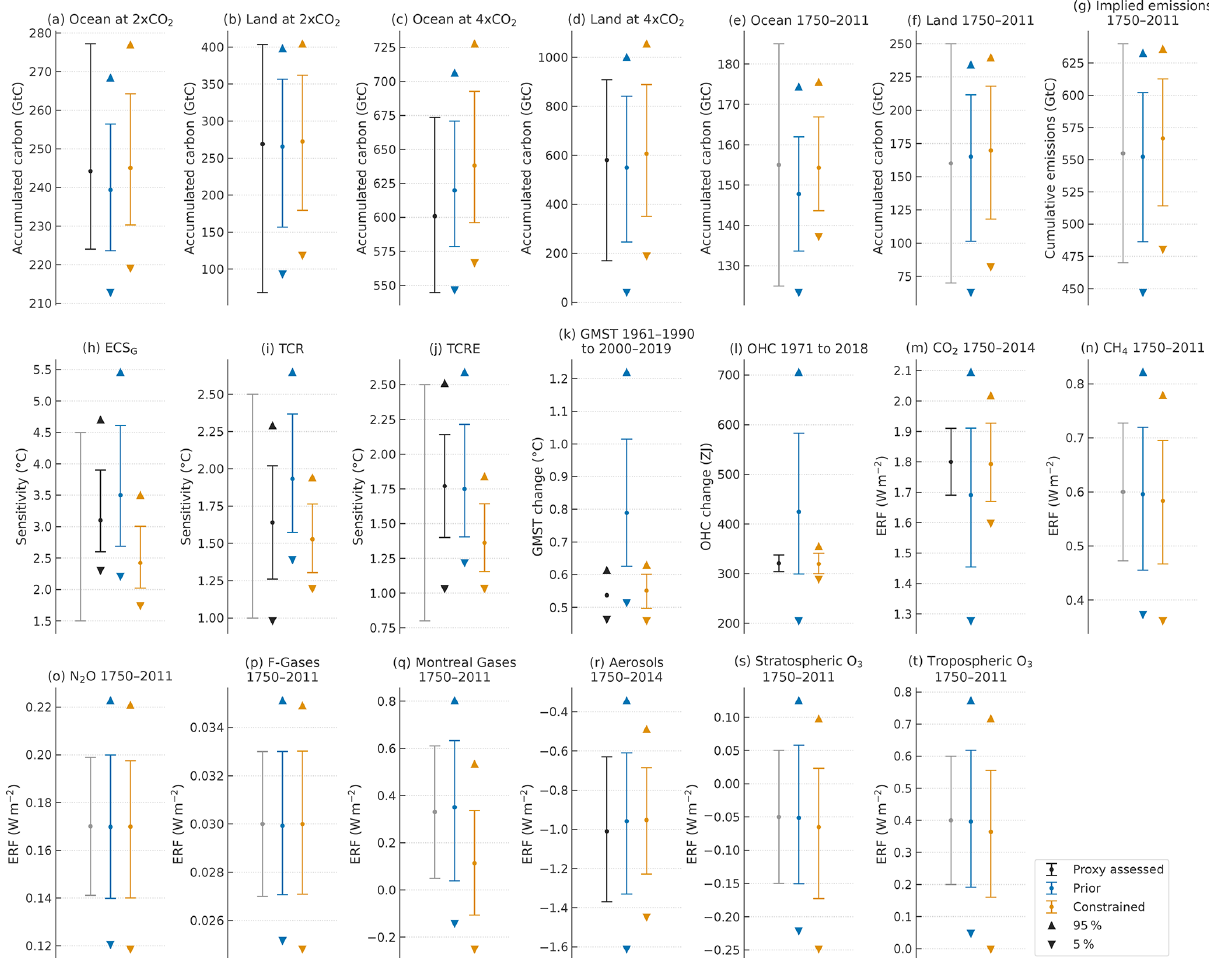
Figure 12. Distributions of climate indicators: (a) accumulated carbon over ocean at doubling CO 2 in 1pctCO2; (b) same as (a) but over land; (c) same as (a) but at quadrupling CO 2 ; (d) same as (c) but over land; (e) accumulated carbon over ocean in 1750–2011; (f) same as (e) but over land; (g) implied cumulative emissions in 1750–2011; (h) equilibrium climate sensitivity diagnosed with CO 2 quadrupling forcing (ECS G ) ; (i) transient climate response (TCR); (j) transient climate response to 1000GtC cumulative CO 2 emissions (TCRE); (k) global mean surface temperature (GMST, air–ocean blended) in 2000–2019 relative to 1961–1990; (l) ocean heat content (OHC) in 2018 relative to 1971; (m) effective radiative forcing (ERF) of CO 2 in 2014 relative to 1750; (n) ERF of CH 4 in 2011 relative to 1750; (o) same as (n) but of N 2 O; (p) same as (n) but of “Montreal gases” (CFCs, HCFCs, halons); (q) same as (n) but of “F gases” (HFCs, PFCs, SF 6 ); (r) same as (m) but of aerosols; (s) same as (n) but of stratospheric O 3 ; (t) same as (n) but of tropospheric O 3 . Error bars and pairs of triangle markers indicate likely ranges (17%–83%) and very likely ranges (5%–95%), respectively. The black and grey error bars indicate proxy assessment ranges and AR5-assessed ranges, respectively. The proxy ranges are based on 5%–95% ranges of the CMIP Earth system models in (a) – (d) but are otherwise taken from the RCMIP Phase 2 protocol that partly includes the AR5-assessed ranges.